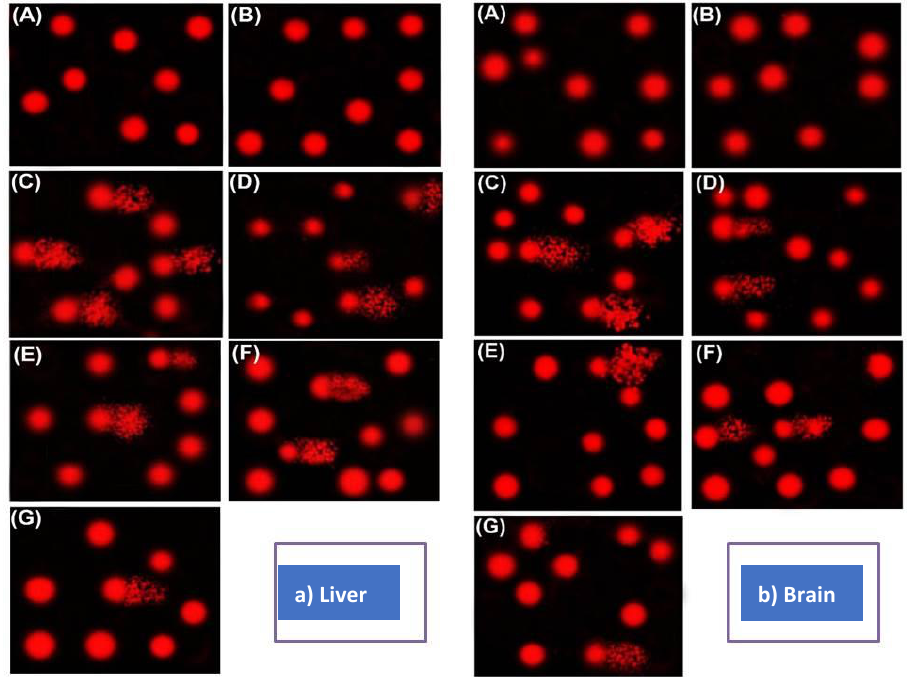
Figure 4. ( a ) Photomicrographs representation of DNA damage, using comet assay, in rat livers of ( A ) G1, ( B ) G2, ( C ) G3-1, ( D ) G3-2, ( E ) G3-3, ( F ) G3-4, and ( G ) G3-5. ( b ) Photomicrographs representation of DNA damage, using comet assay, in rat brains of ( A ) G1, ( B ) G2, ( C ) G3-1, ( D ) G3-2, ( E ) G3-3, ( F ) G3-4, and ( G ) G3-5.